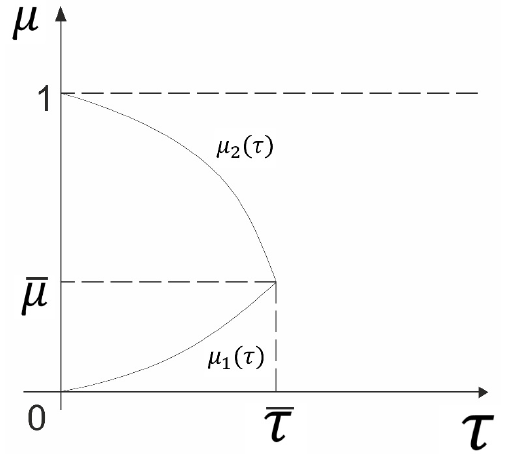
Figure 3. Functions μ 1 (τ) and μ 2 (τ).